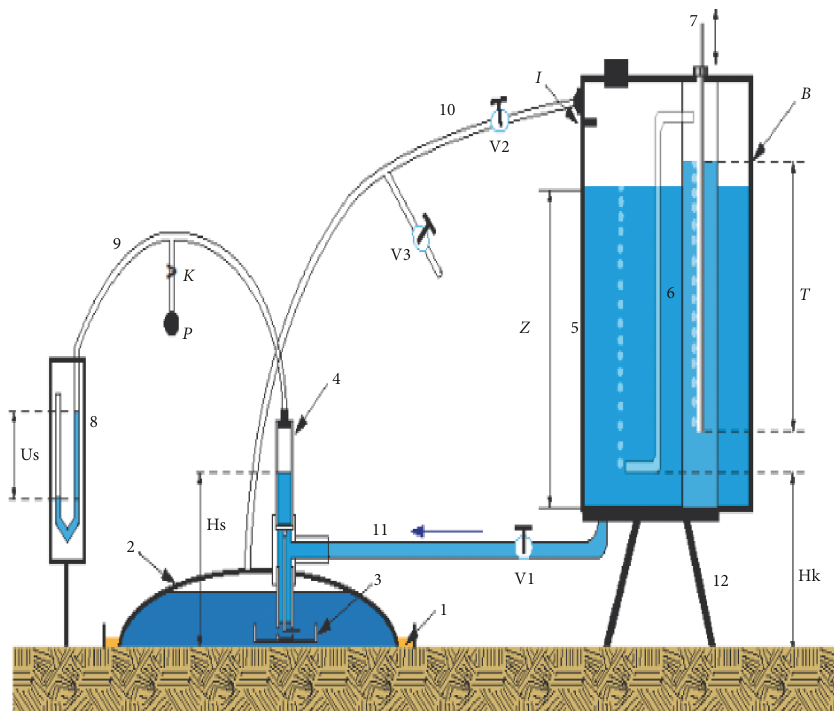
Figure 2: Schematic setup of the Hood infiltrometer [34]. (1) Fine sand sealing; (2) plastic hood; (3) buffer vessel; (4) standpipe; (5) infiltration reservoir; (6) bubble tower; (7) air intake pipe; (8) U-tube manometer; (9) hose connection 1; (10) vent pipe; (11) hose connection 2; (12) stand. B : filling level of the bubble tower; Hk: distance between soil surface and air outlet; Hs: water level in the standpipe; I : the maximum filling level of the infiltration reservoir; K : valve for cutting off the pipette ball; P : pipette ball; T : immersion depth of the air intake pipe; Us: height difference at the U-tube manometer; V1: valve for separating the water volumes; V2: valve for separating the air volumes; V3: valve for pressure adjustment; Z : filling height of the infiltration